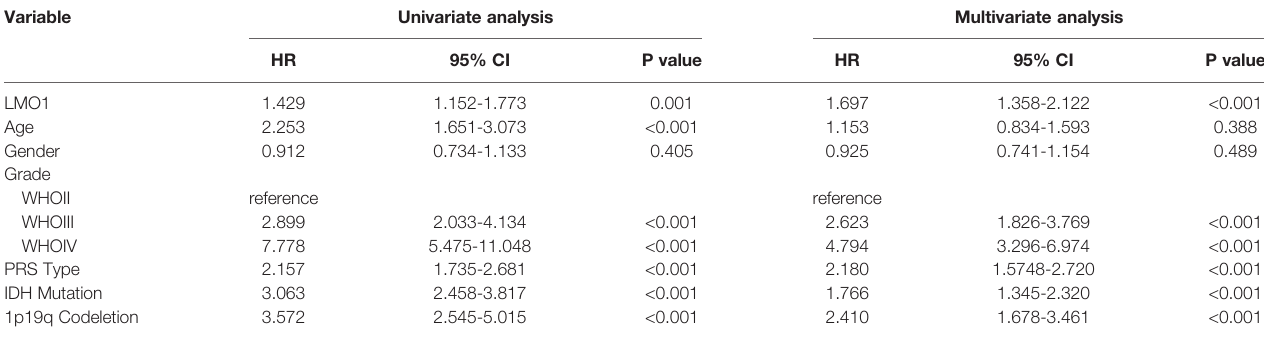
TABLE 2 | Univariate and multivariate Cox regression analysis for OS in GBM patient based on CGGA (n = 542). Variable